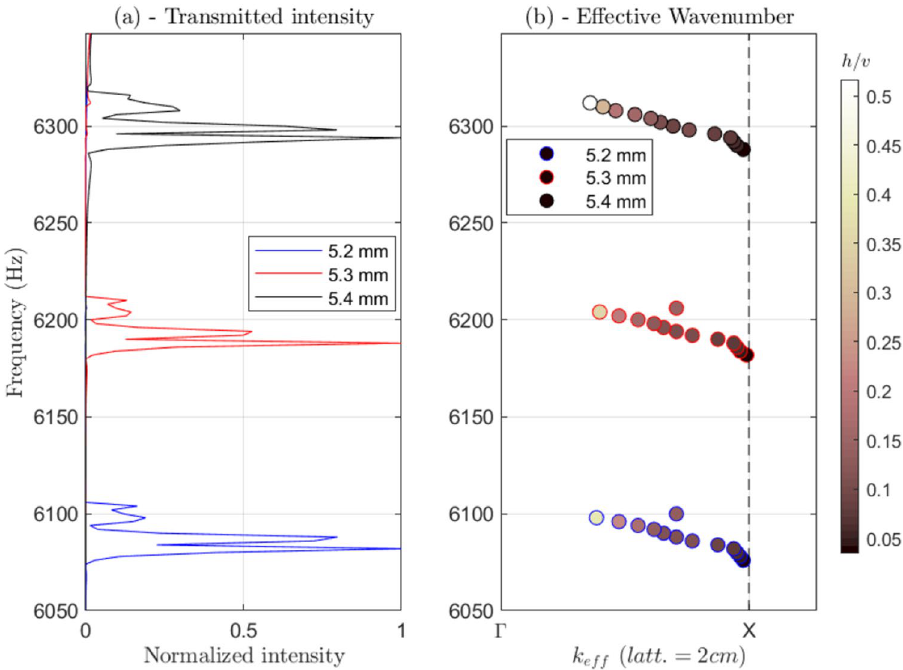
Figure 4. ( a ) Normalized transmission coefficients for the three simulations (blue, red, black) that create three different leakages. ( b ) Band structure of the created waveguides (blue, red, black circles). The color scale in ( b ) depicts the wave polarization through the u/v ratio (i.e., tangential vs. normal components), computed from the spatial Fourier